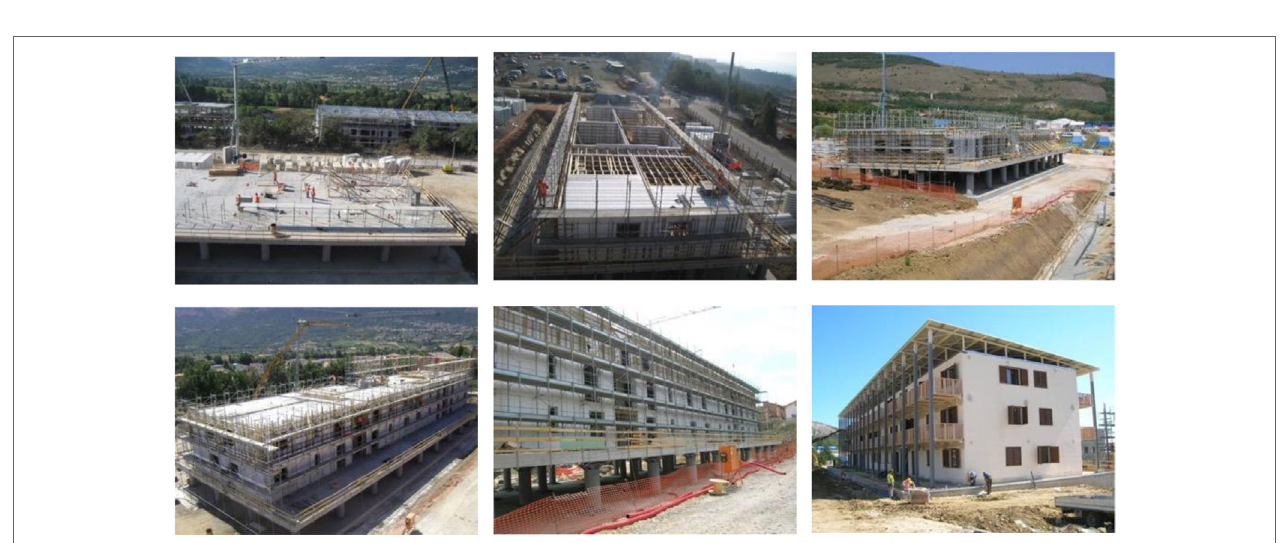
FigURe 11 | Work phases (“Piano C.A.S.E.”) (from the top left to the bottom right) day 1: work initiation; day 4: positioning of the slab modular panels; day 7: first floor completed; day 11: second floor completed; day 17: structure completed; day 73: building ready to be occupied (courtesy of Nidyon Costruzioni).